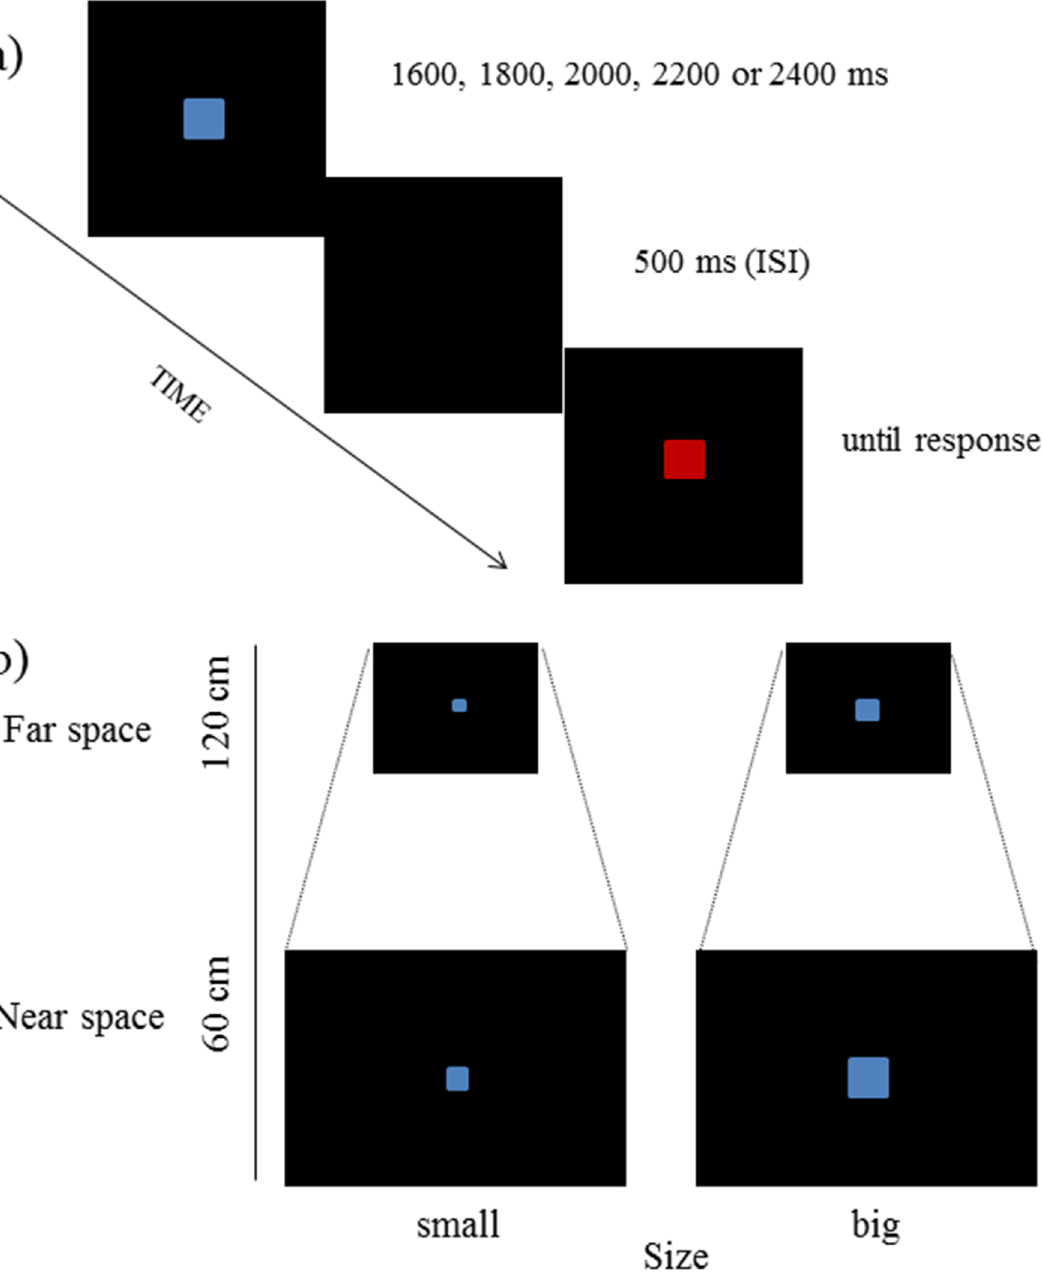
Fig 1. Stimuli used in the temporal bisection task. (a) Temporal structure of a representative trial. (b) Stimuli dimension depicted according to near and far